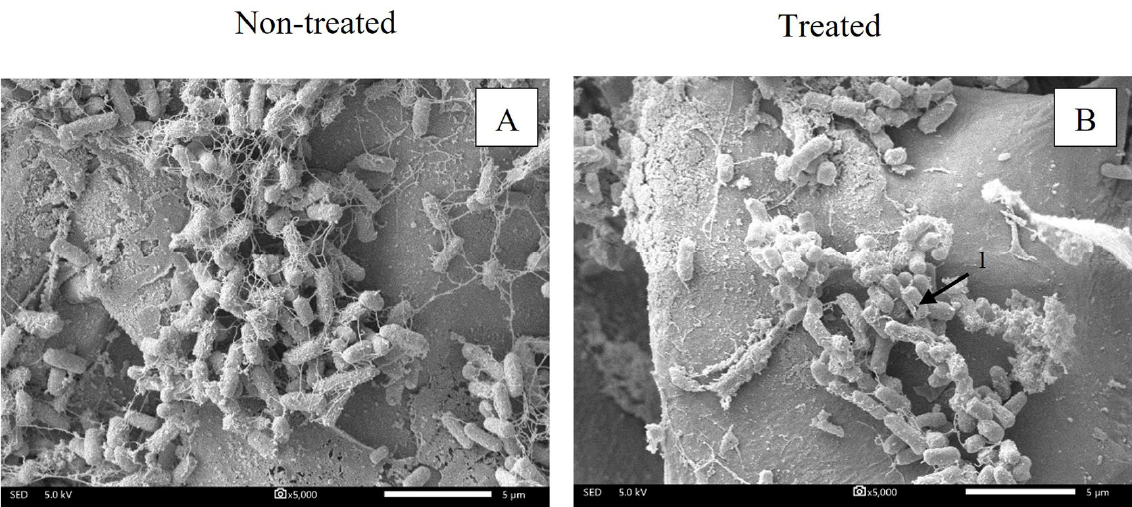
Figure 4. Scanning electron micrographs of E. aerogenes on coconut husk at 5000 × magnification; non-treated ( A ) and treated with 15:20% ( w/v ) salt/acid solution for 10 min ( B ), respectively. Holes on cell surface (arrow #1).